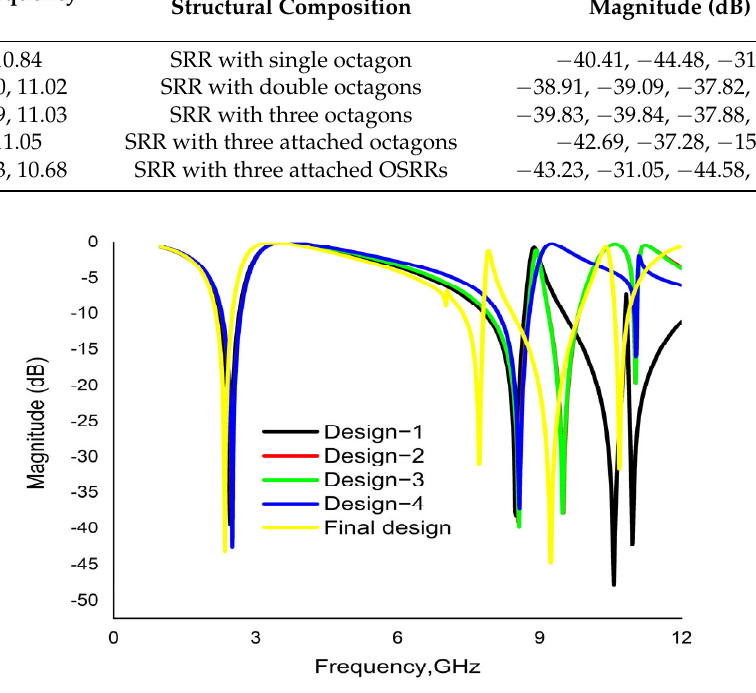
Figure 3. CST result of transmission coefficient (S